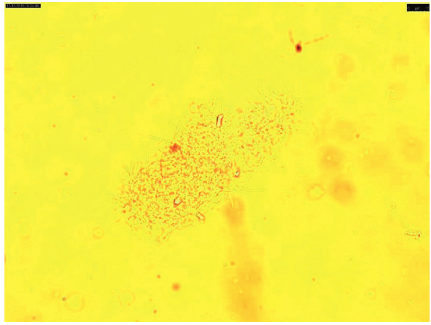
Figure 3: KOH mount showing branching filament-like structures.